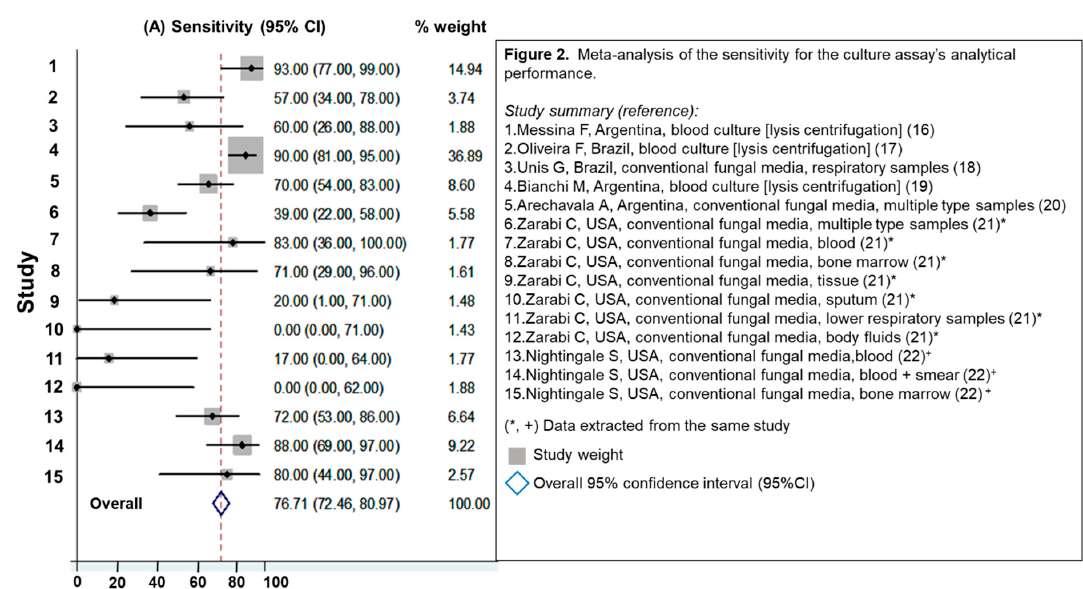
Figure 2. Meta-analysis of the sensitivity for the culture assay’s analytical performance.